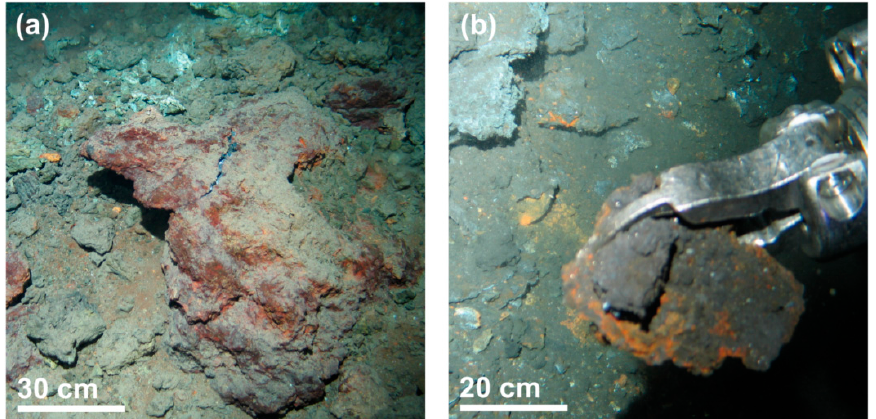
Figure 3. Example grab samples of suspected hydrothermal vent material, with ( a ) possible conduit structures implying fluid channels and ( b ) rust implying Fe derived from